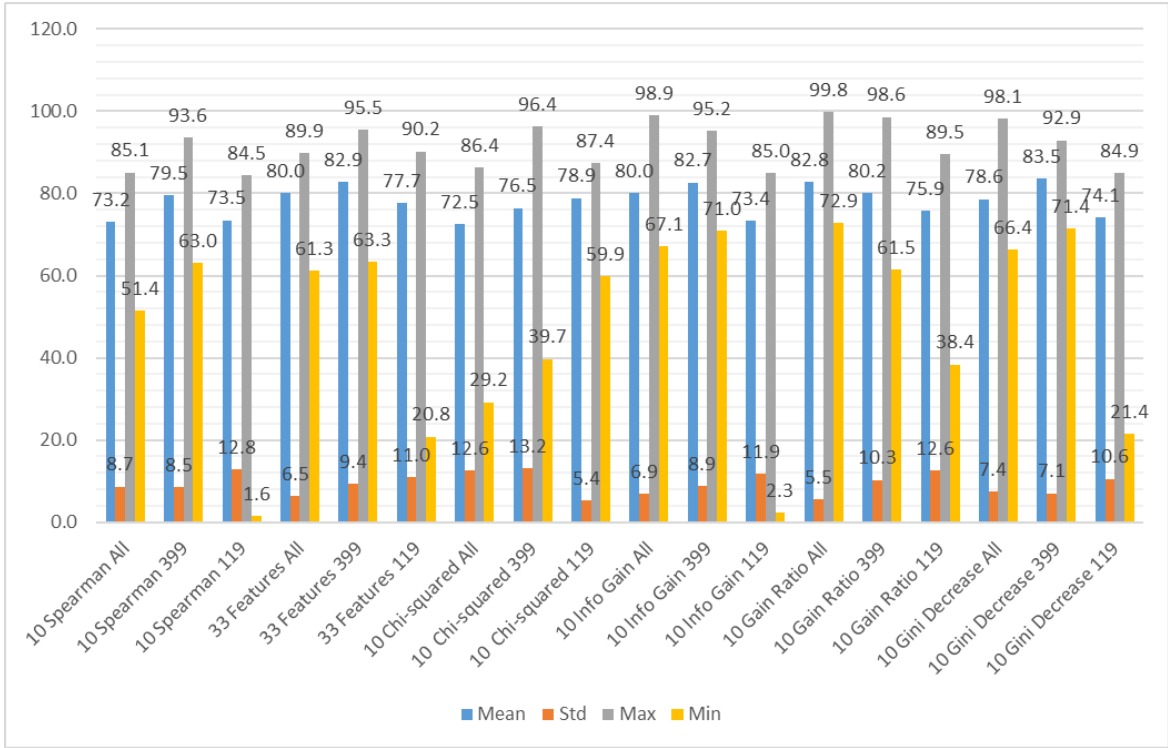
Figure 9. Aggregated specificity results grouped by feature